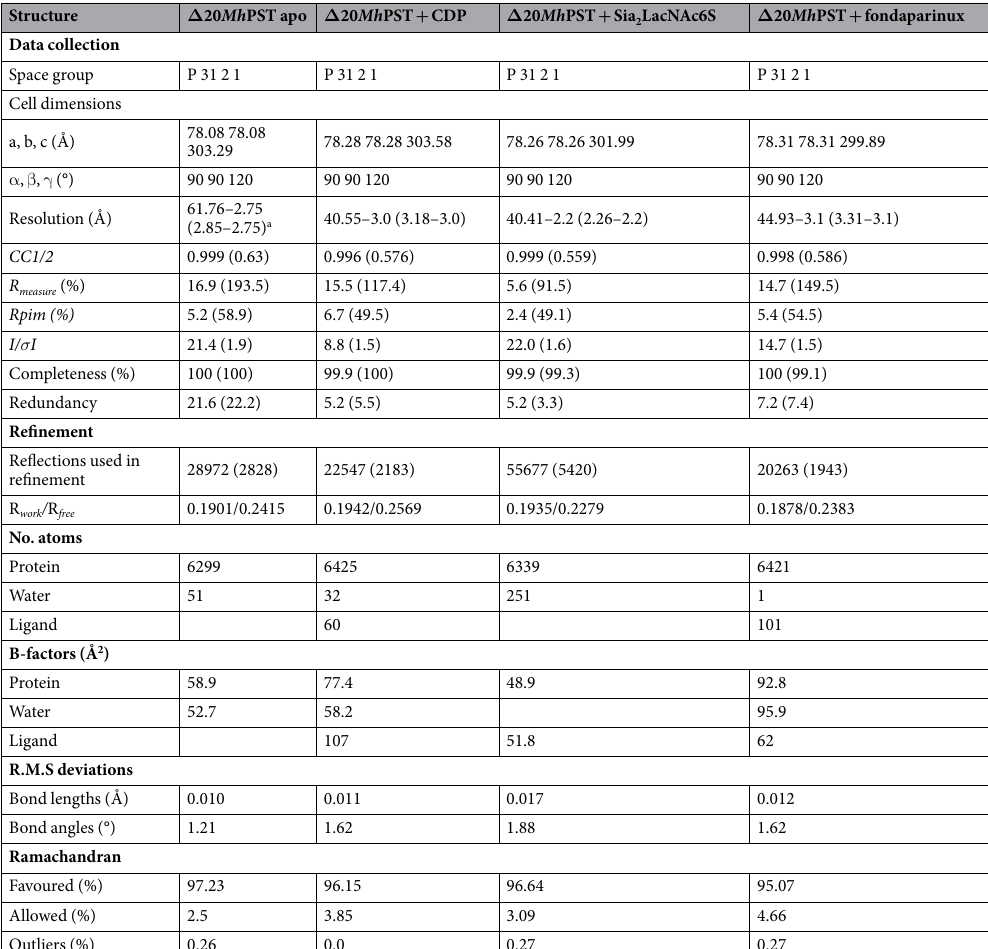
Table 2. Data collection and refinement statistics. a Numbers in parenthesis refer to the highest resolution